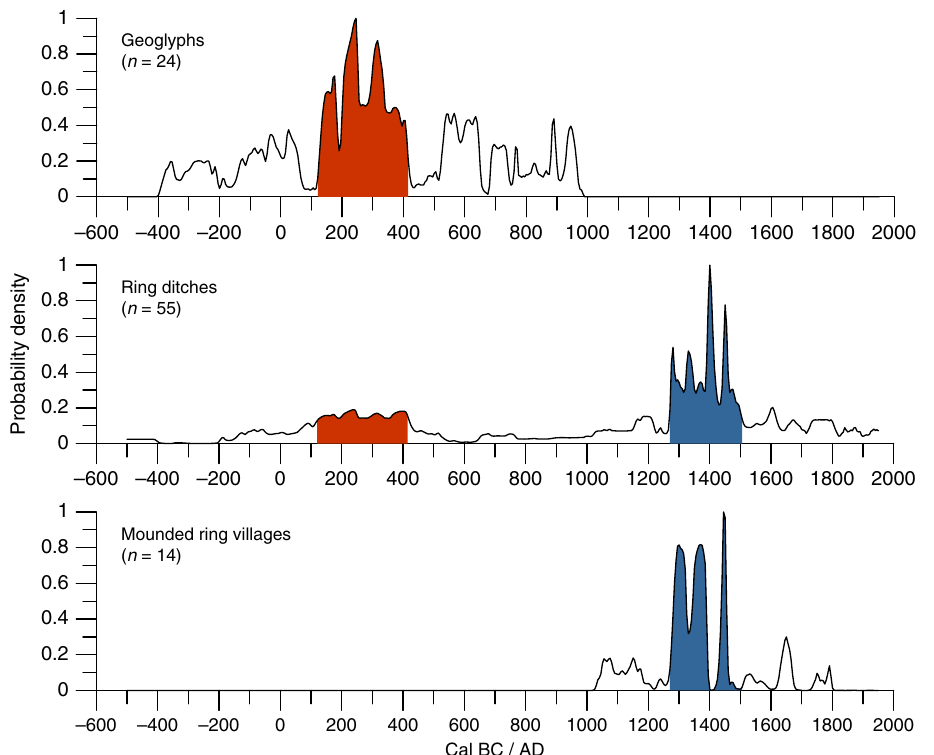
Fig. 5 Sum of the probability distributions (SPDs) of radiocarbon dates for earthworks in the SRA. Curves are shown for different categories of earthworks. Peaks in site construction and occupation are highlighted for geoglyphs/early ring ditches (red) and later ring ditches/mounded ring villages (blue).